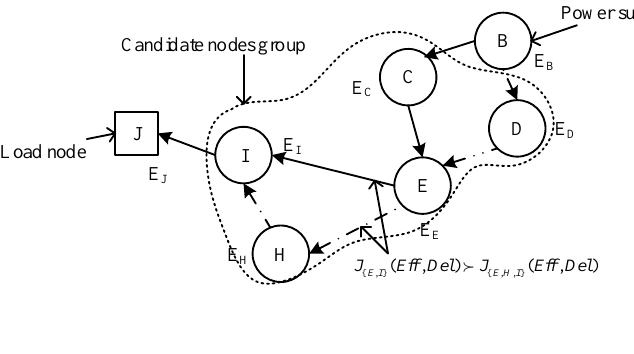
Figure 5. Energy link comparison.